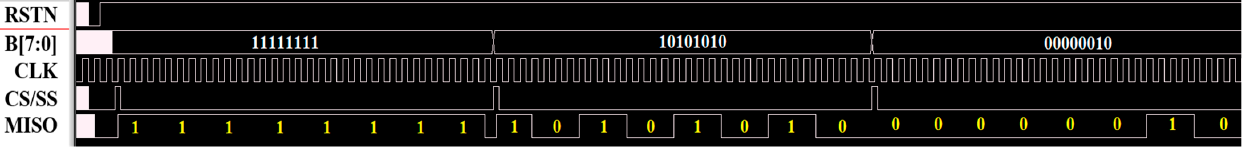
Figure 15. SPI block post-layout simulation.